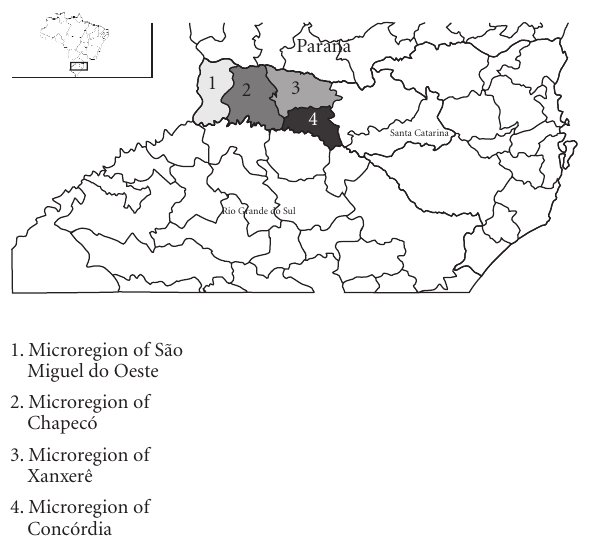
Figure 2: Western region of the state of Santa Catarina, Brazil, from the Brazilian Institute of Geography and Statistics, 2010.